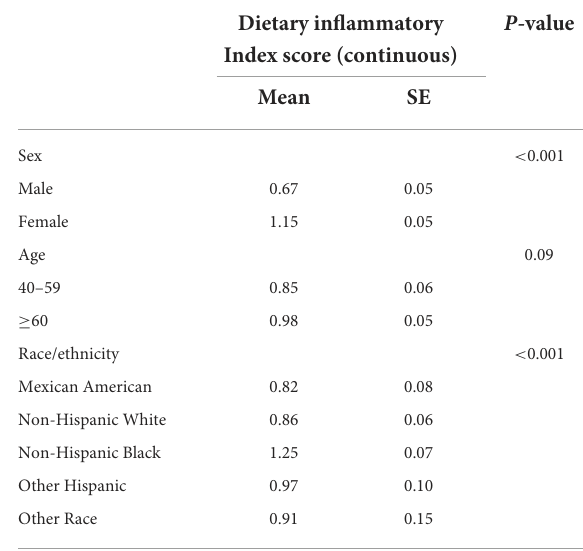
TABLE 3 Characteristics of osteoporosis (OP) participants by modified dietary inflammatory index (MDII) score. Dietary